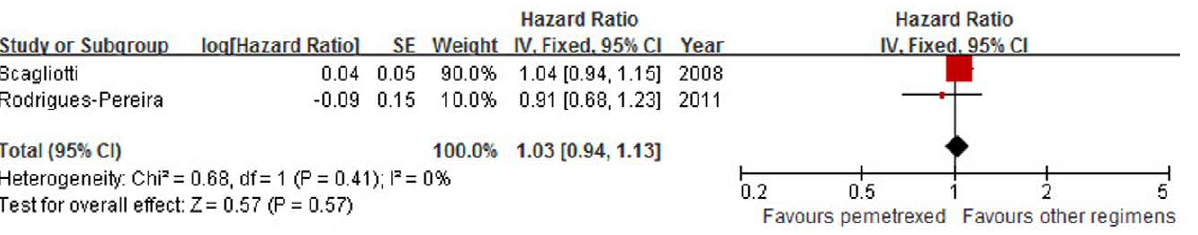
Figure 4. Comparison of progression-free survival between pemetrexed plus platinum chemotherapy and other platinum-based regimens. Abbreviations: SE, standard error; IV, inverse variance; CI, confidence interval.